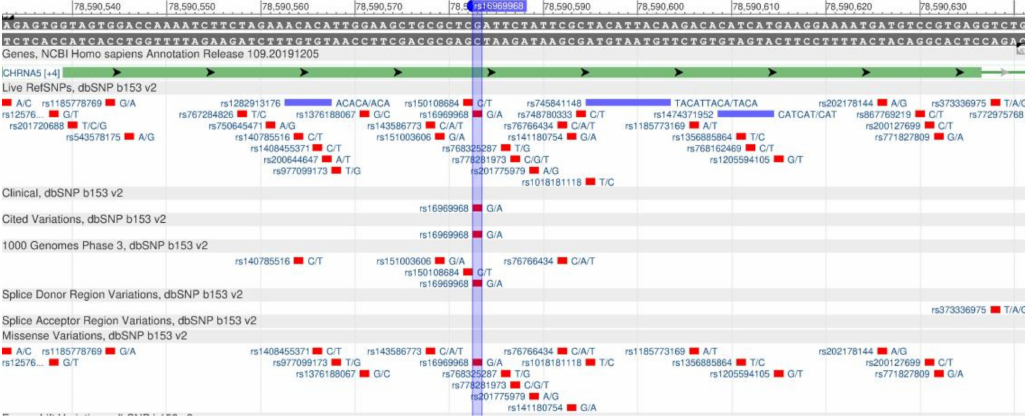
Figure 38. A portion of the CHRNA5 gene (located on the long (q) arm of chromosome 15) containing the oligonucleotide polymorphism rs16969968.